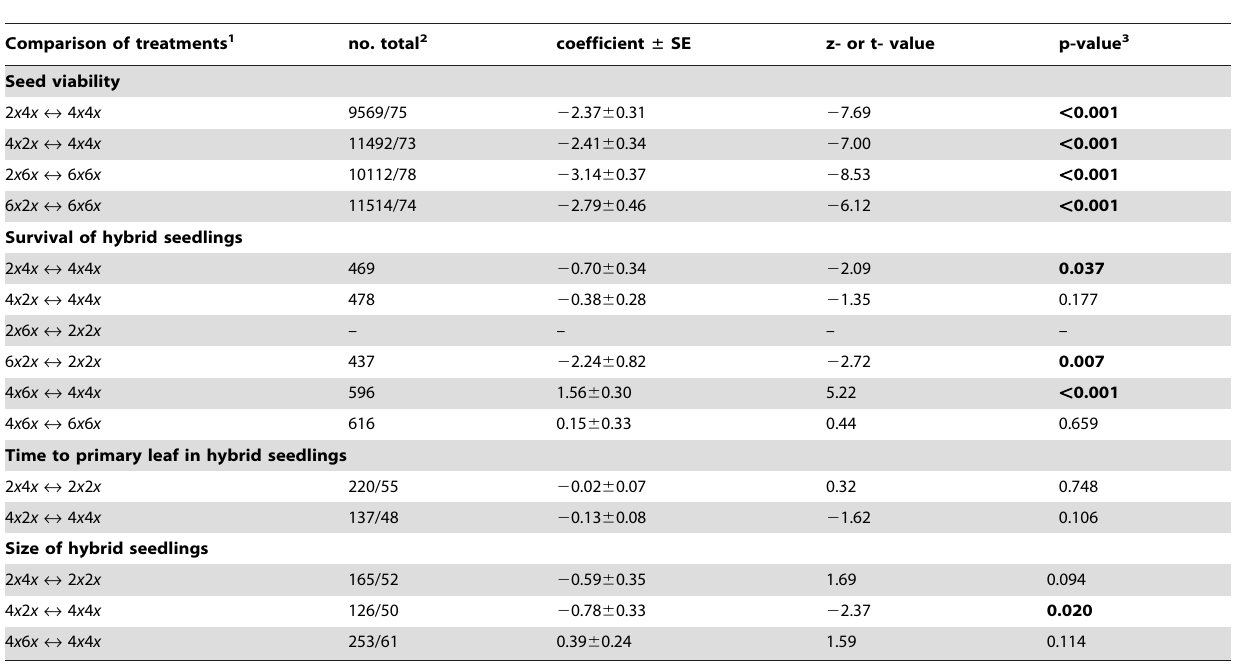
Table 3. Test for parental-like fitness components of heteroploid crosses of Jacobaea carniolica .